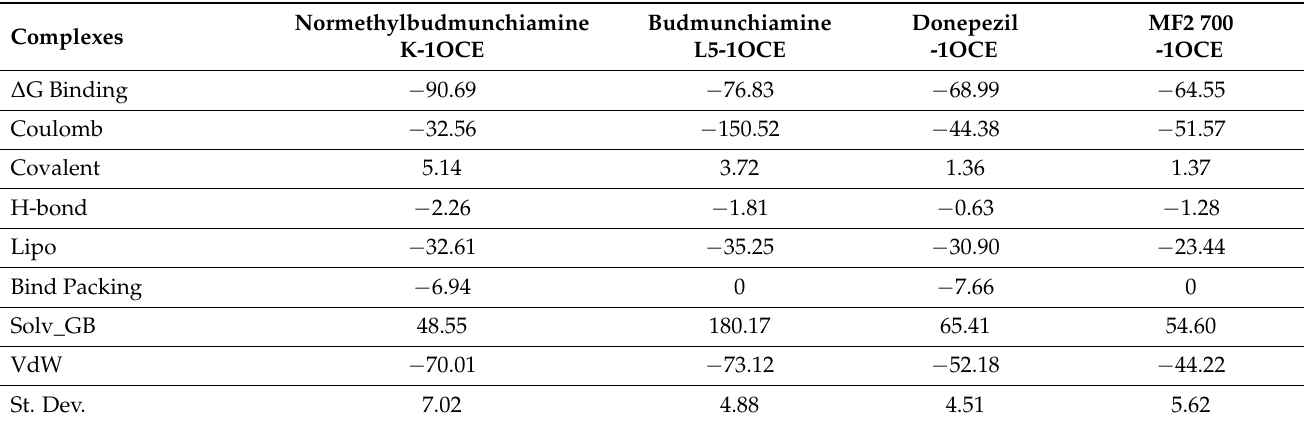
Table 5. Prime MM-GBSA energies for the best two alkaloids compared to both donepezil and the co-crystallized MF2 700 inhibitor binding at the active site of the 1OCE receptor